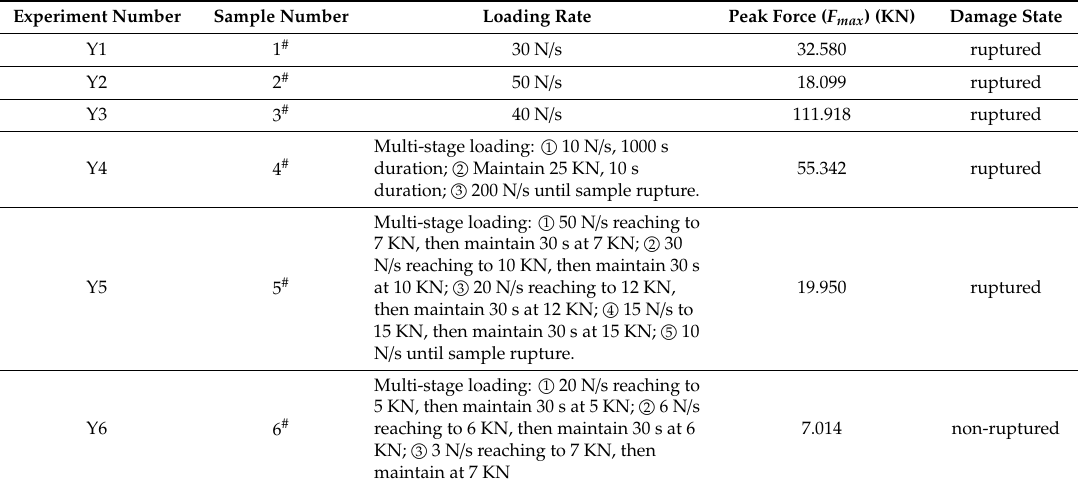
Figure 3. The test apparatus and arrangement of MS sensors. Table 1. Experimental scheme and damage of raw coal specimens.